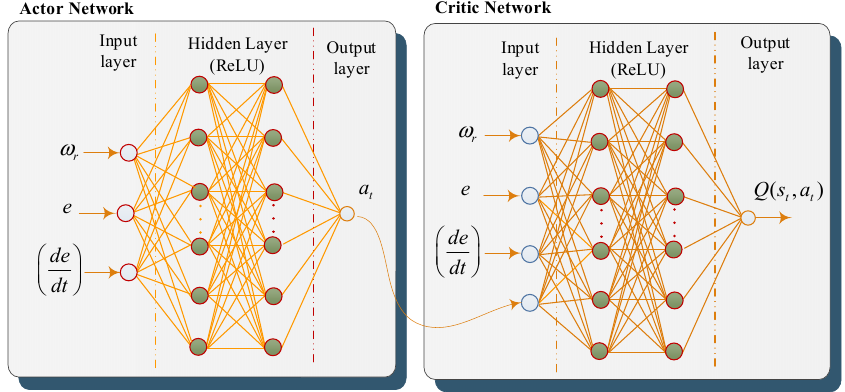
Figure 5. Structure of the actor neural network (ANN) and critic neural network (CNN).